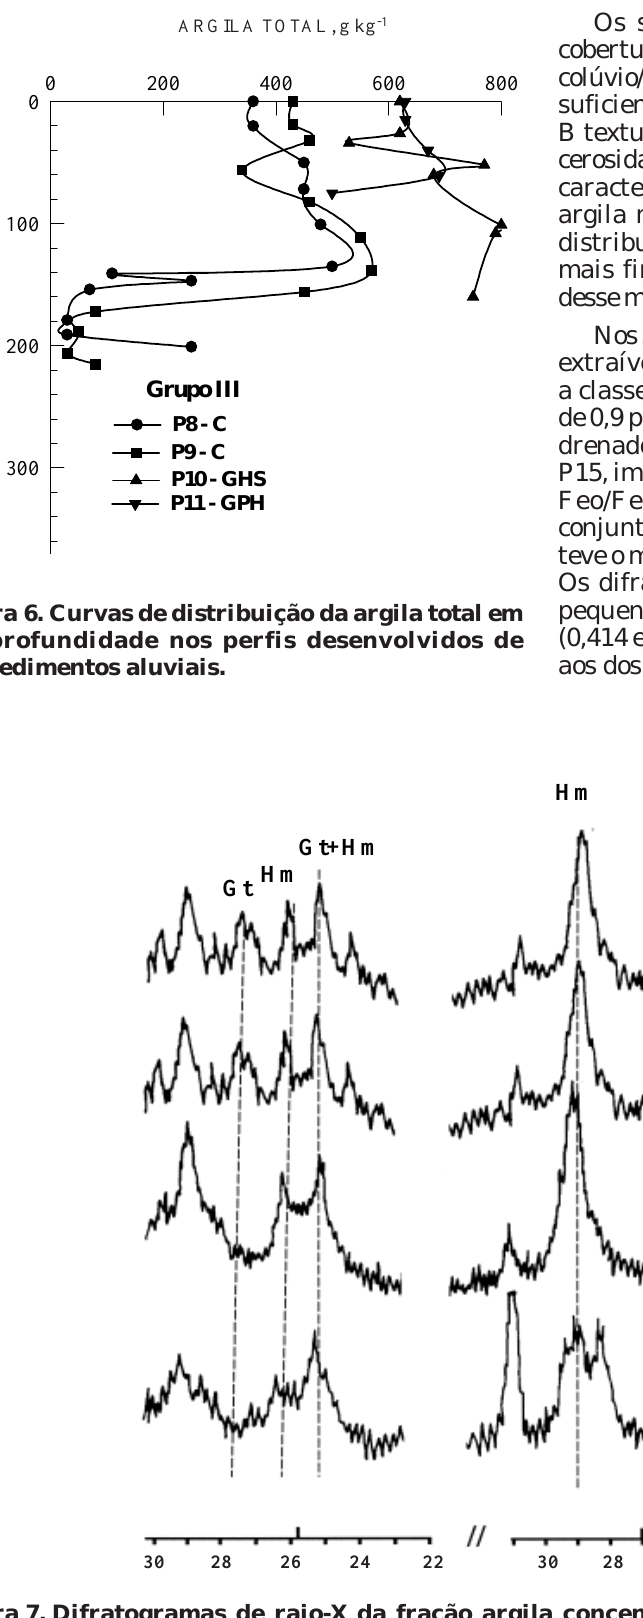
Figura 7. Difratogramas de raio-X da fração argila concentrada com NaOH 5M (não orientada) dos horizontes diagnósticos subsuperficiais dos perfis desenvolvidos de sedimentos aluviais (Hm: Hematita e Gt: